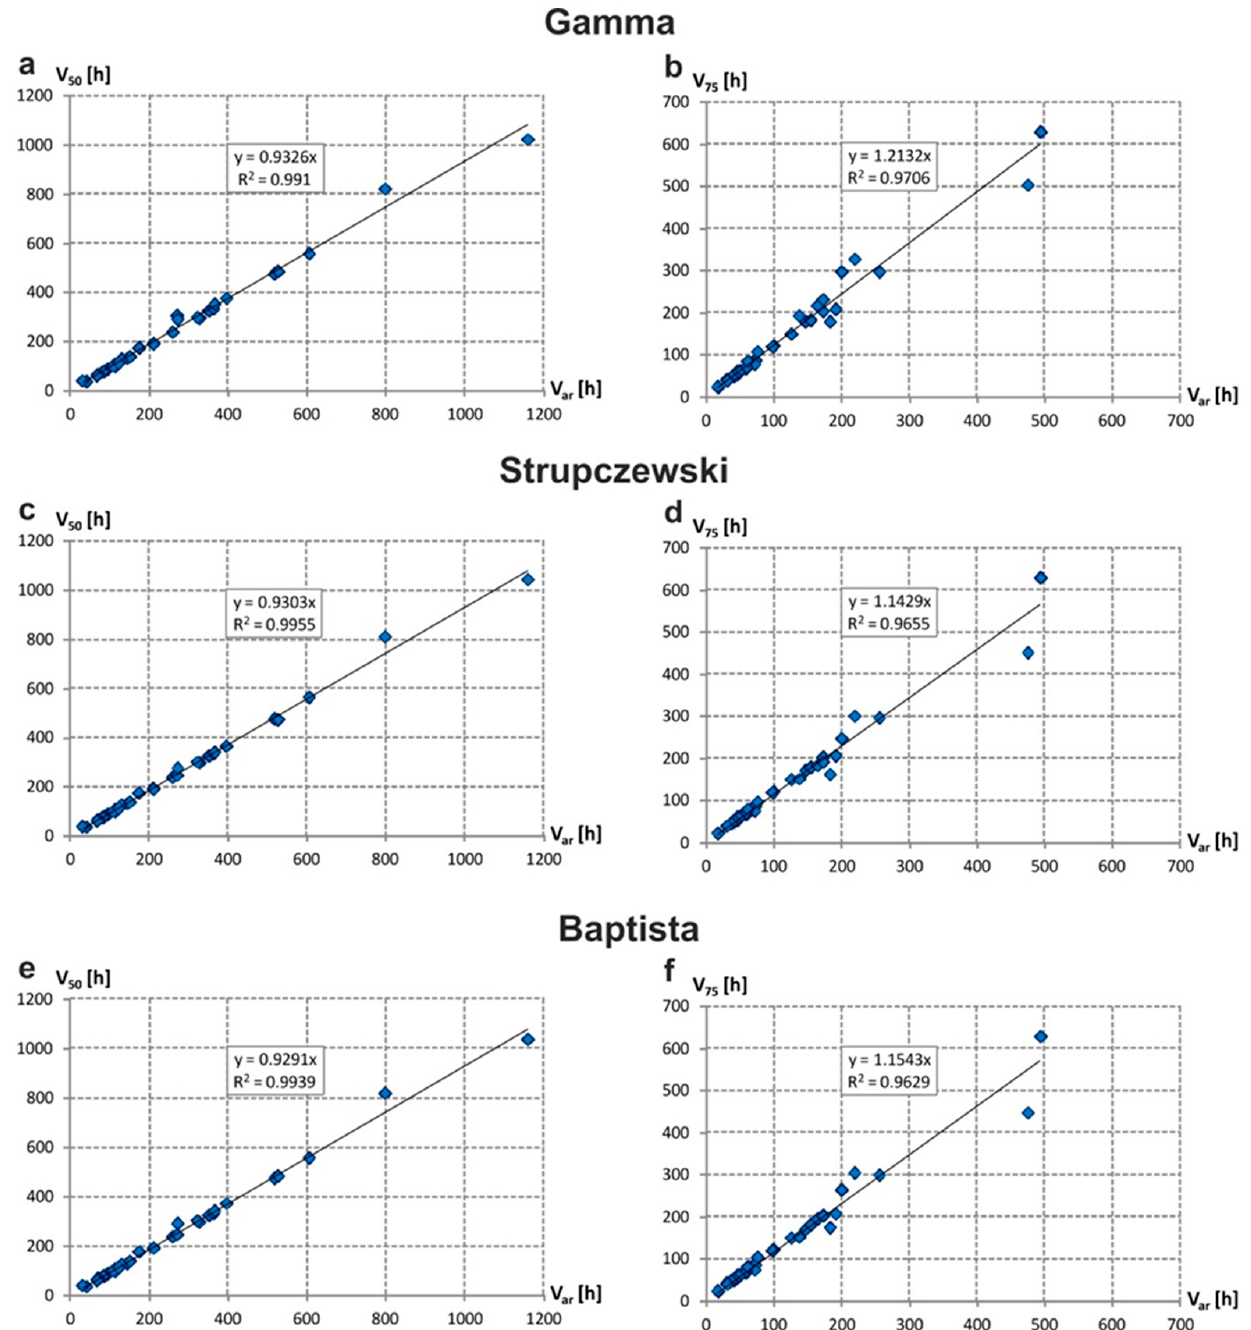
Figure 10. The values of flood wave volume estimated from parametric hydrograph methods (Gamma, Strupczewski, Baptista) V p versus values estimated with nonparametric DFH by Archer method truncated at p = 50% (left panel) and at p = 75% (right panel).